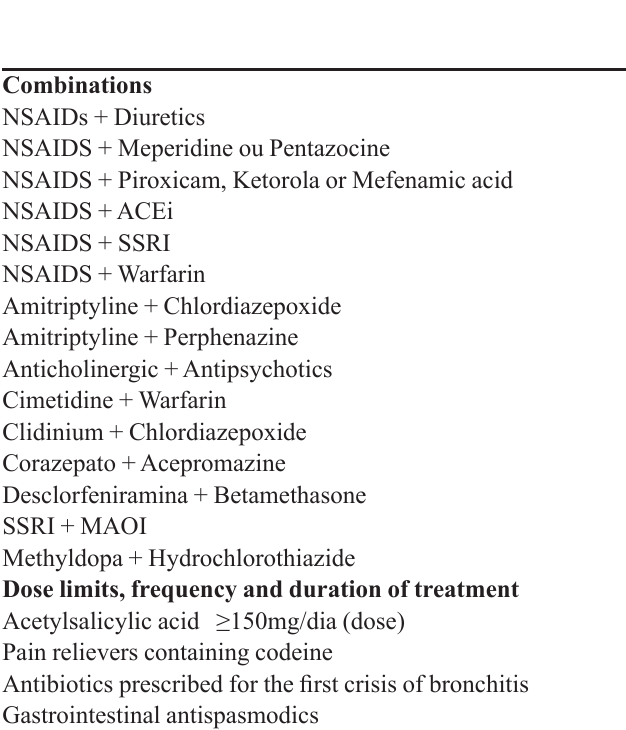
TABLE IV - List of potentially inappropriate medications (PIM) for the elderly that should be avoided as indicated by the clinical diagnosis of the patient (drug interaction with disease), the dose, frequency and duration of the drug administration and drug association, according to the methods identified in PAHO (available at: http://regional.bvsalud.org/php/index.php), Lilacs and Pubmed databases, during the period between February and March 2010 (n=10)